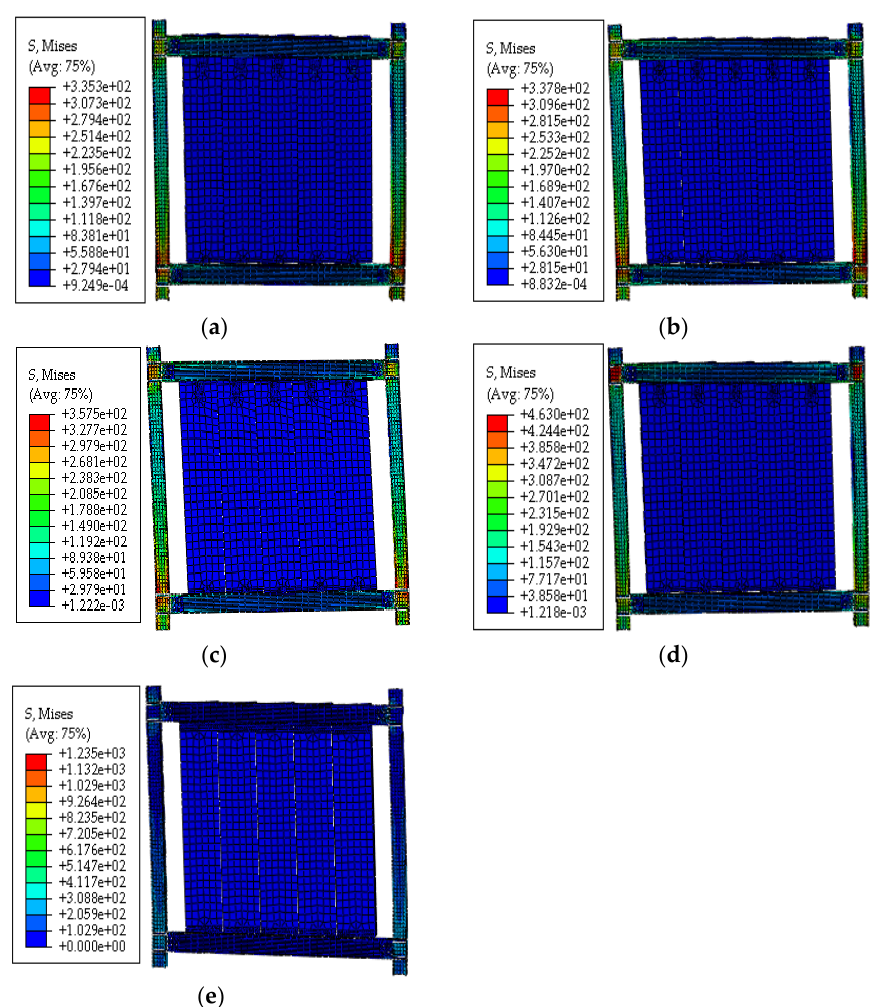
Figure 24. Stress clouds images: ( a ) TK-6; ( b ) TK-8; ( c ) TK-10; ( d )TK-12; and ( e ) GT. Table 6. ALC panel bolt hole stress. Specimen